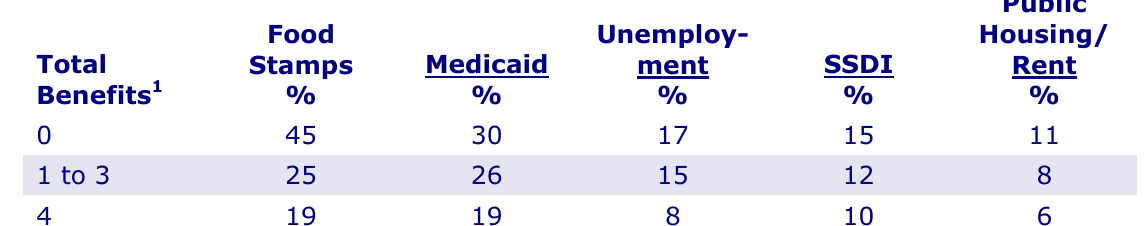
Table 6: Relationship between Benefits and Use Of Government Assistance in